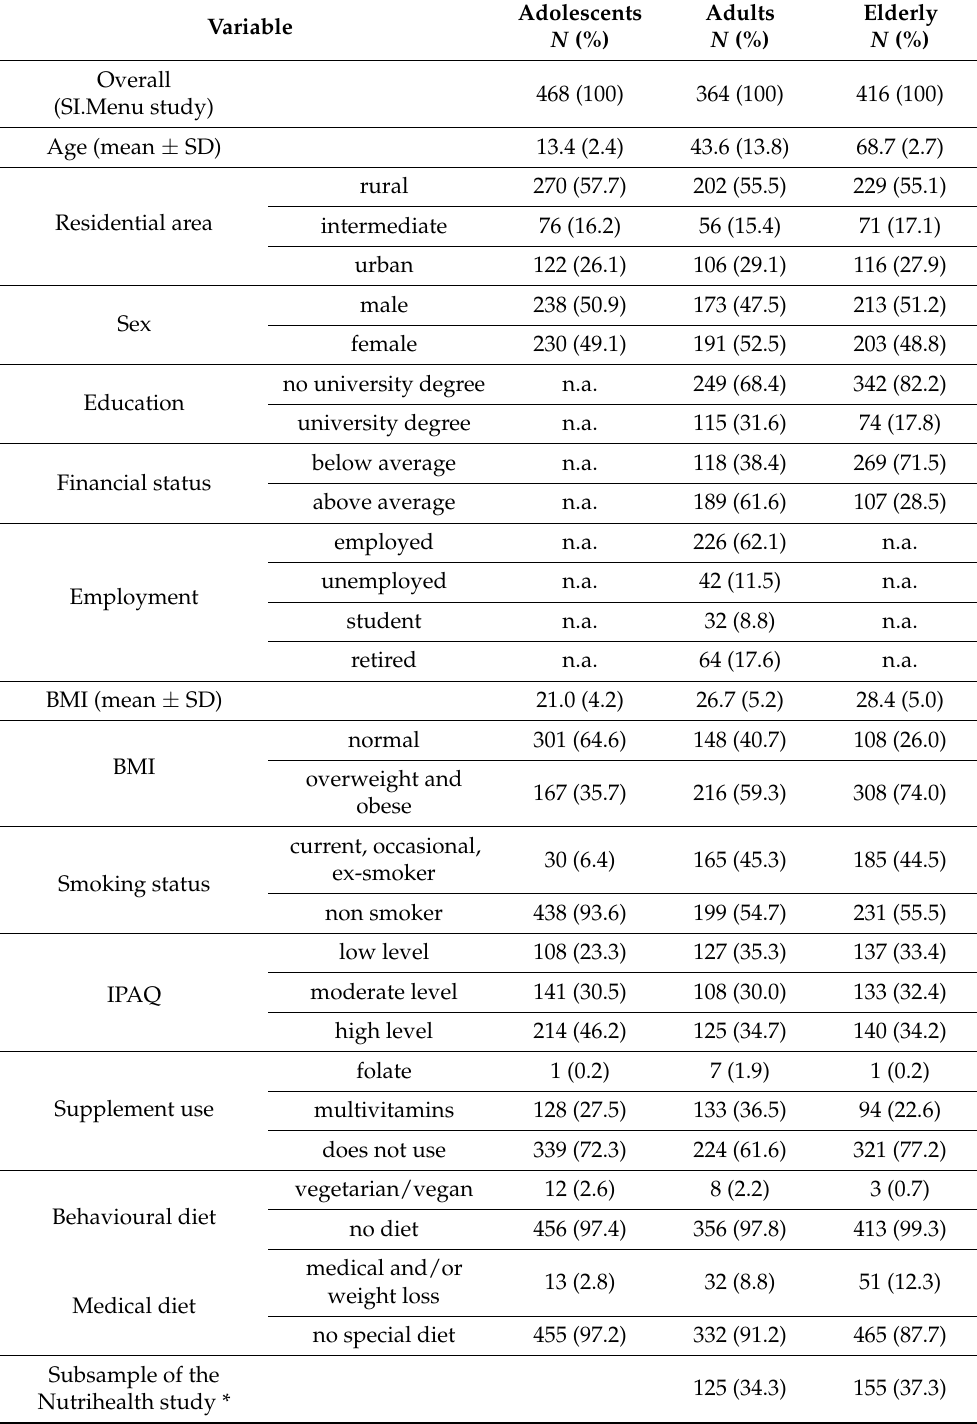
Table 1. Demographic characteristics of the SI.Menu study sample for all three age cohorts (adoles- cents: 14–17 years; adults: 18–64 years; elderly: 65–74